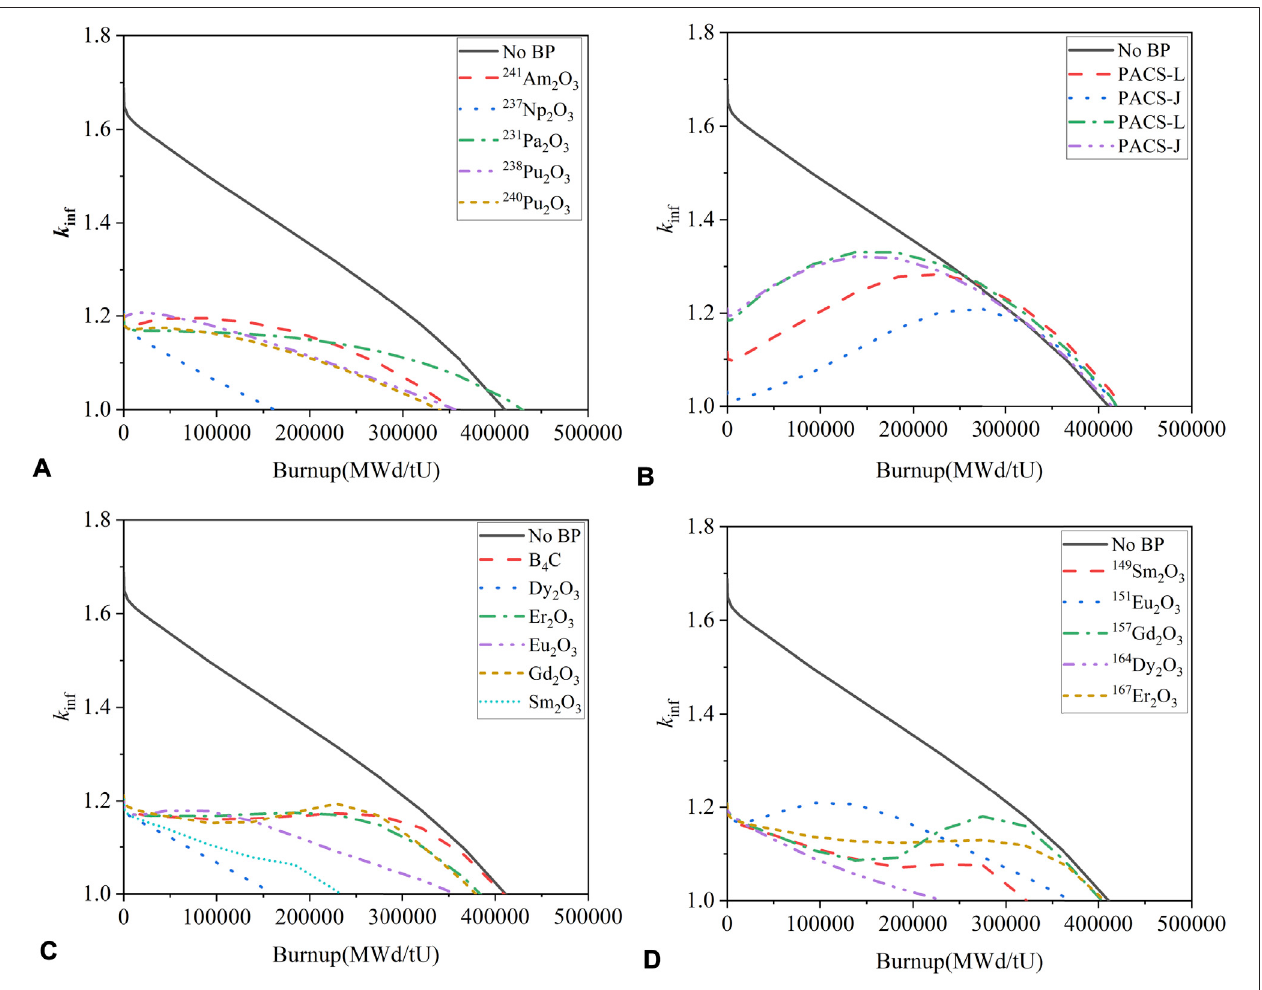
FIGURE 3 | Variation in the k inf of assembly with different BPs